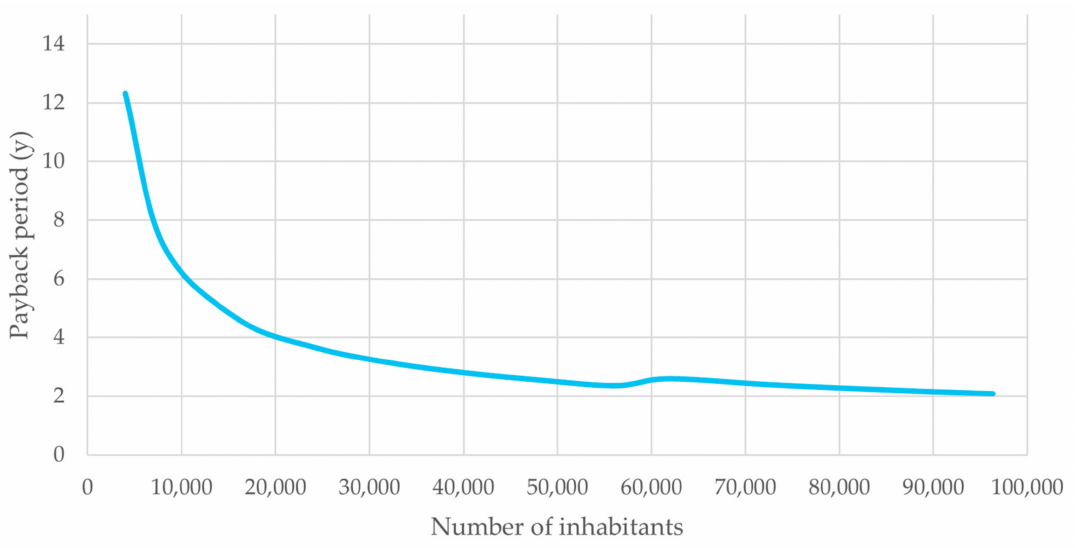
Figure 7. The payback period for the system with a different number of